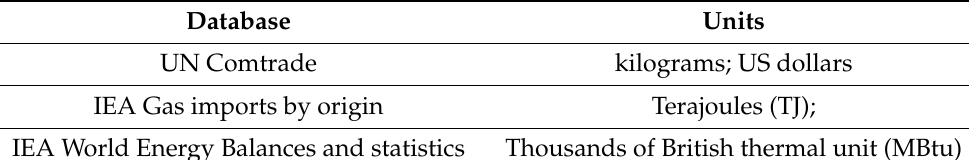
Table A1. Used Databases and corresponding data units.